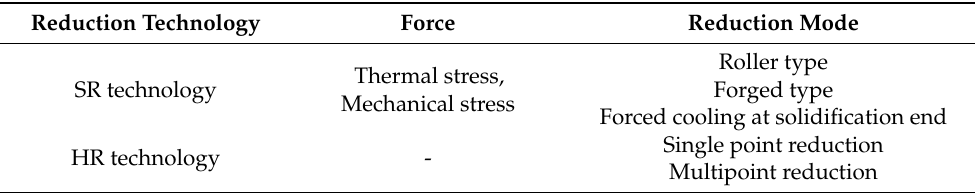
Table 4. Classification of reduction technology.